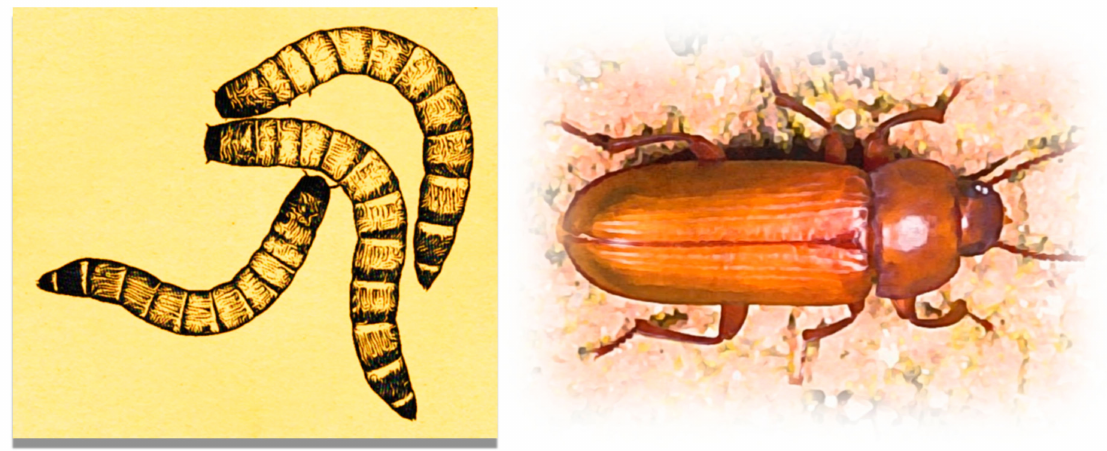
Figure 2. The larval form of the mealworm ( left ) and the adult insect ( right ).